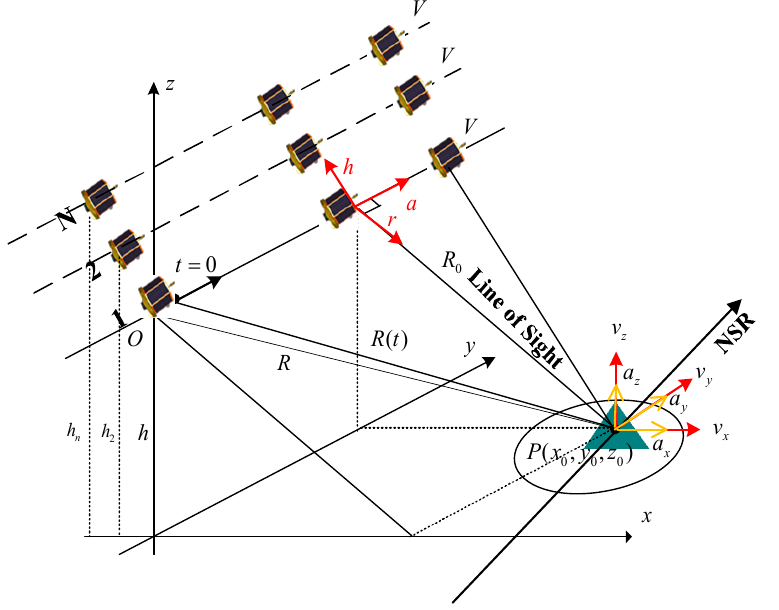
Figure 2. Model for the SAR moving target 3D imaging.